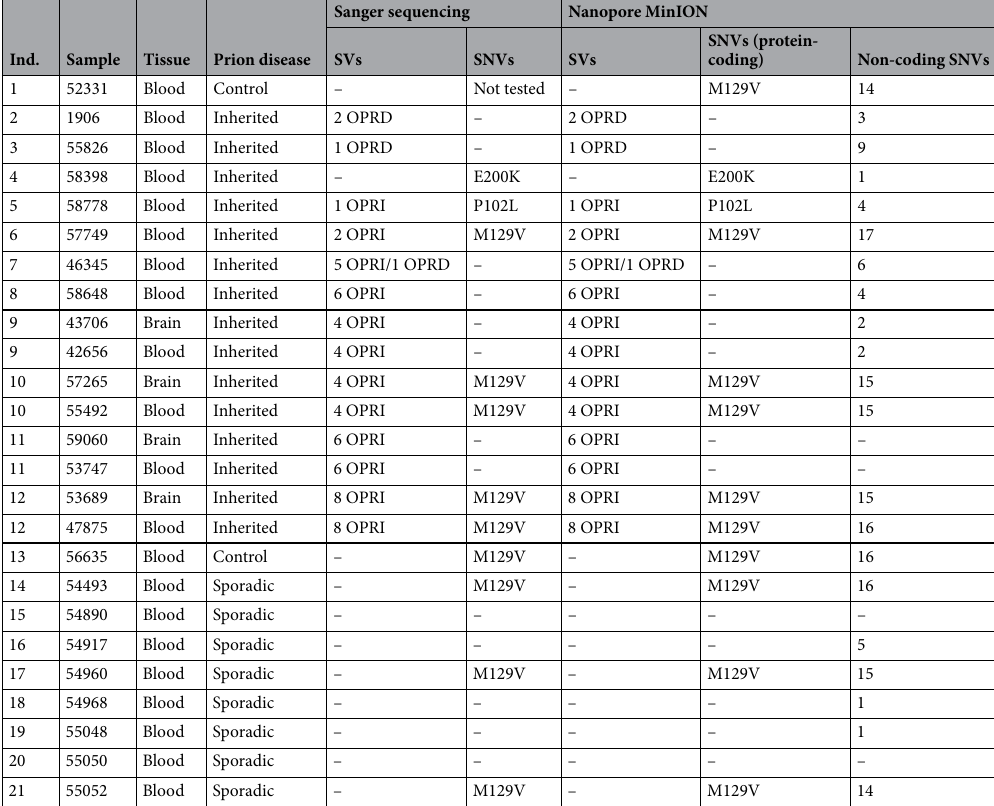
Table 1. Samples information and genotyping summary. Ind., individual; Sample, sample unique identifier; Tissue, source of the genomic DNA sequenced; Prion disease, healthy control or inherited or sporadic CJD. Sanger sequencing columns list SVs and SNVs detected by Sanger sequencing of PRNP ’s protein-coding region. Nanopore MinION columns list SVs and SNVs detected by Nanopore sequencing of the PRNP genomic